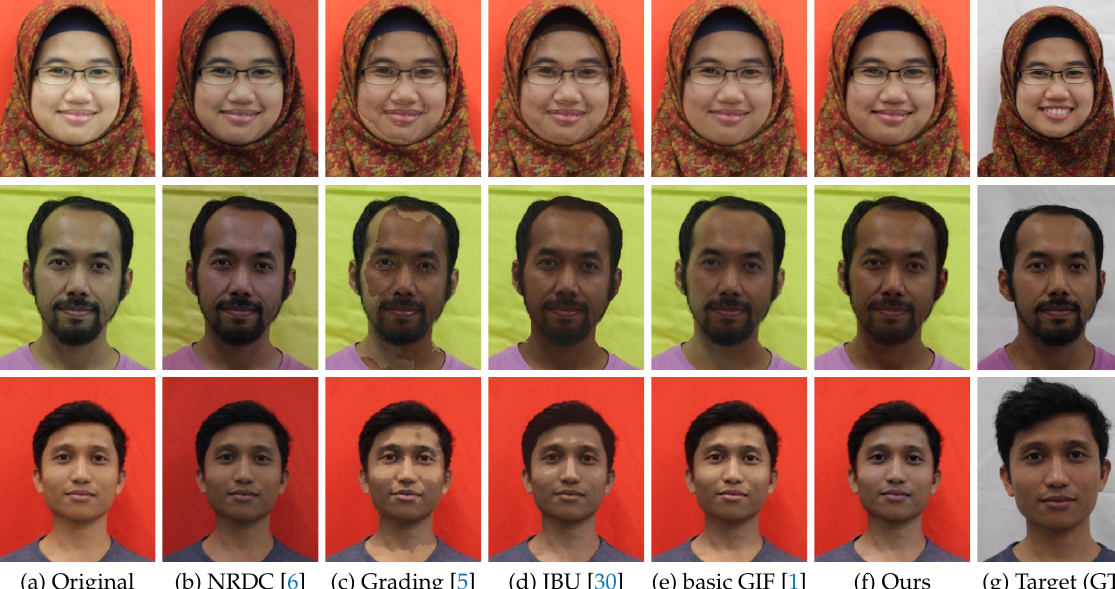
Figure 13. Skin color restoration. ( a ) original; ( b ) NRDC [6]; ( c ) color grading [5] used in our 1st step and the result simply pasted on ( a ); ( d ) JBU [30]; ( e ) He et al.’s basic GIF [1] instead of our GIF; ( f ) our method; and ( g ) target and ground